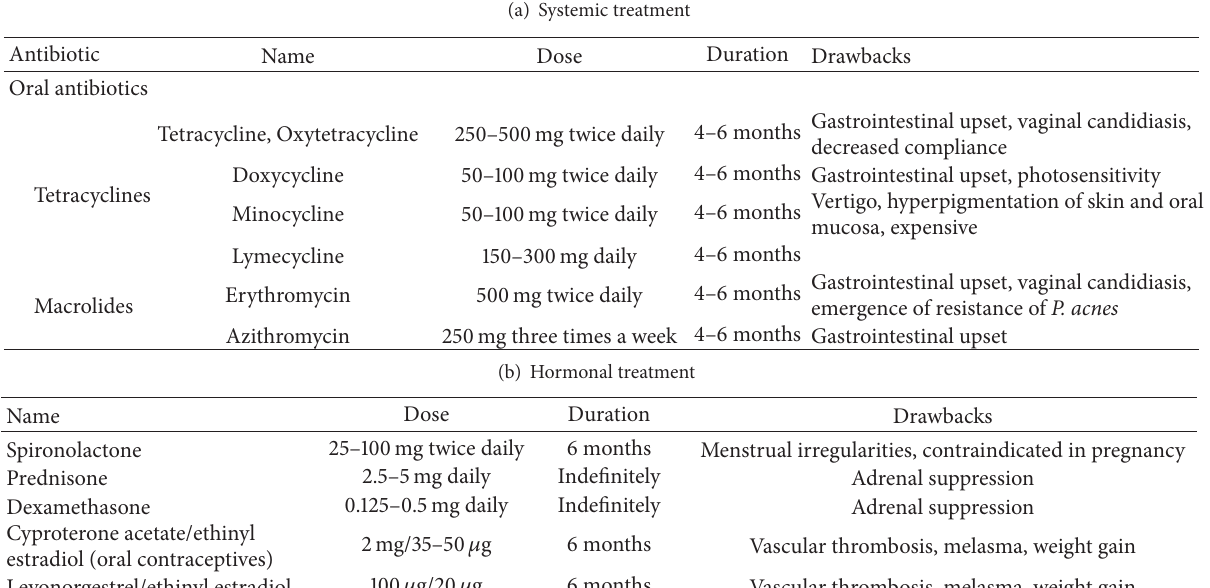
Table 3: Systemic and hormonal treatment for